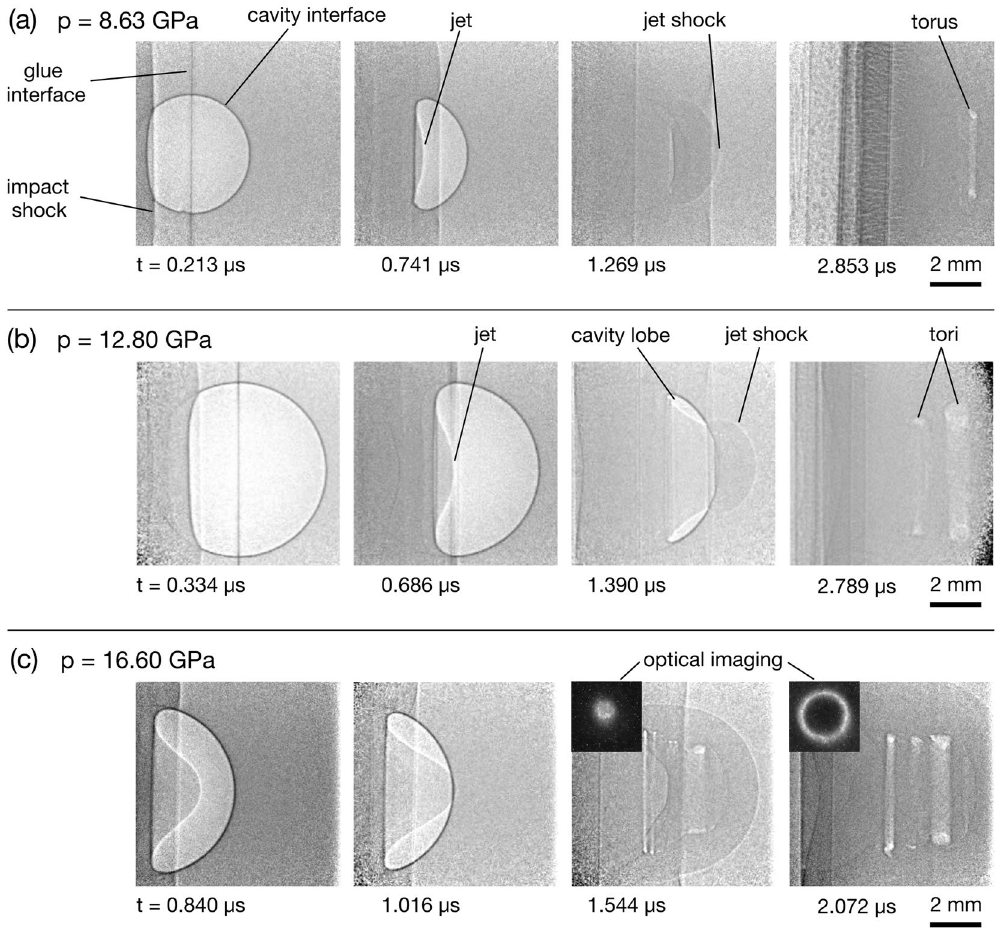
Figure 5. Radiograph sequences showing shock-cavity interactions in the hydrodynamic regime. ( a ) A 4 mm cavity and 8.63 GPa shock. ( b ) A 6 mm cavity and 12.80 GPa shock. ( c ) A 6 mm cavity and 16.60 GPa shock, with insets showing the rear-surface optical images of the toroidal plasma